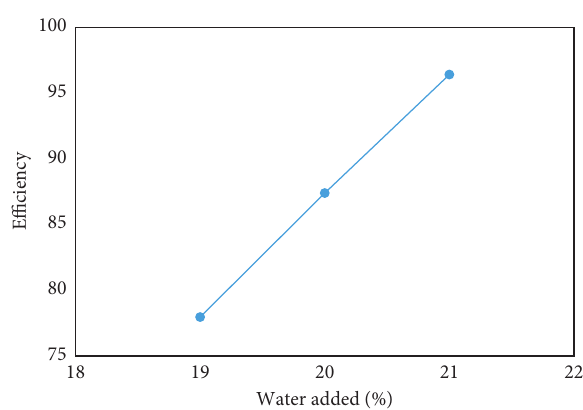
Figure 2: Pelletization efficiency with respect to water content.